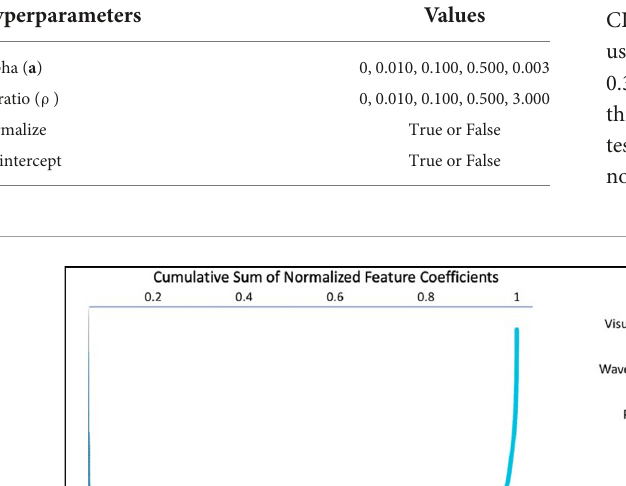
TABLE 2 Searched values of Elastic Net hyperparameters.